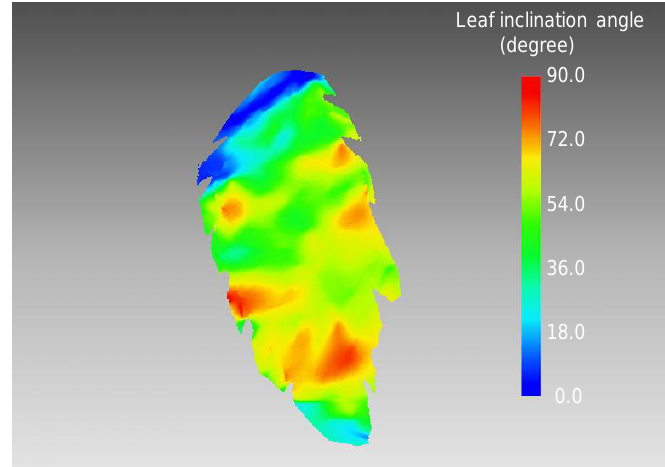
Figure 7. Distribution of leaf inclination angle on a polygon surface image of a certain